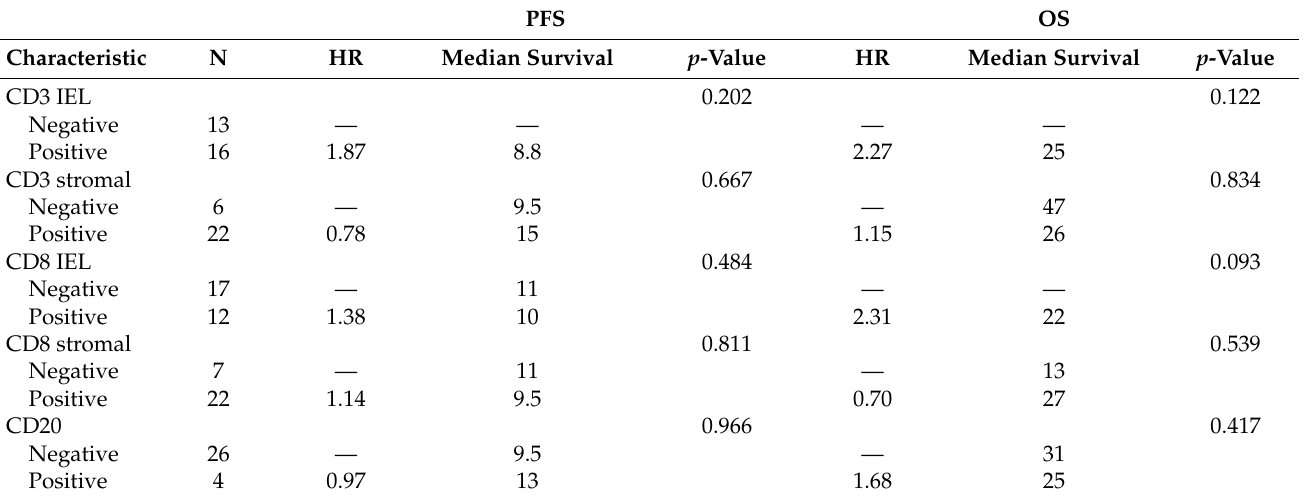
Table 5 . Correlation between FoxP3 and CD68 expression in malignant melanoma group.